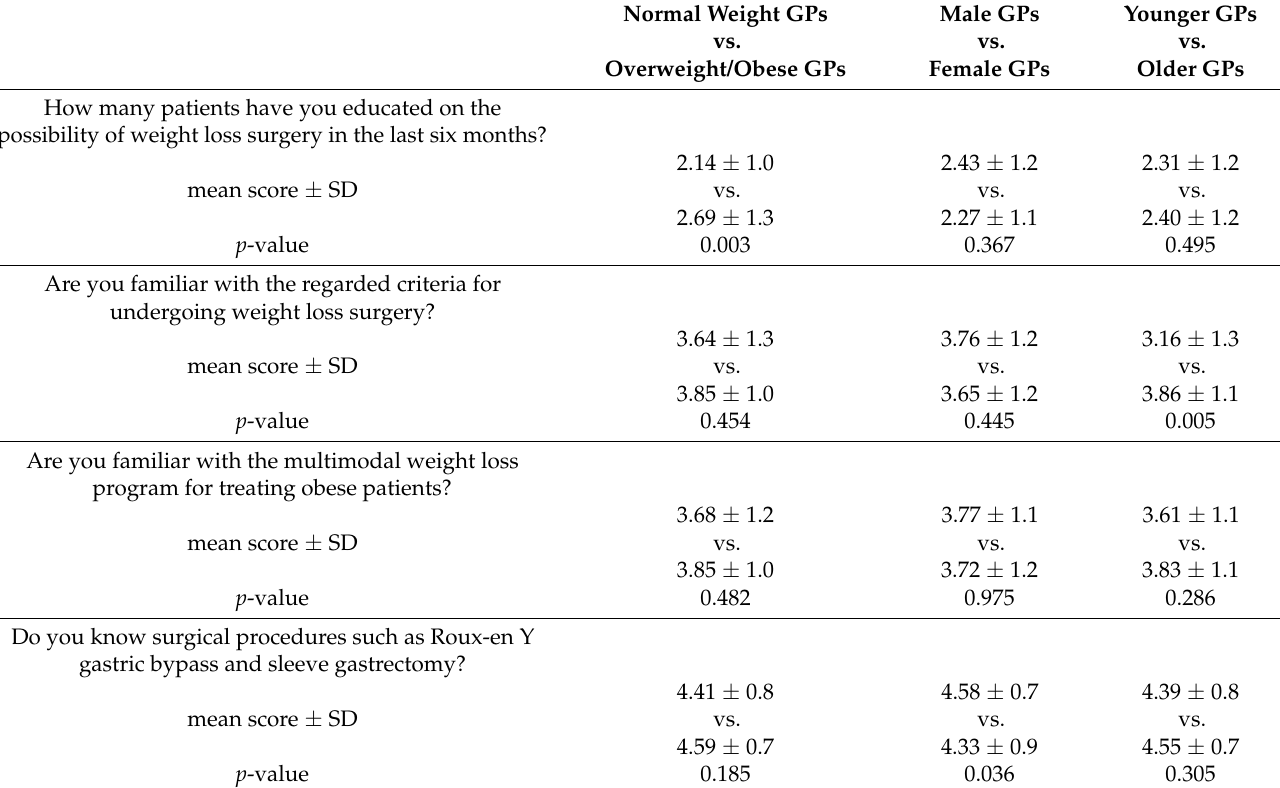
Table 5. Knowledge regarding WLS in context with GPs’